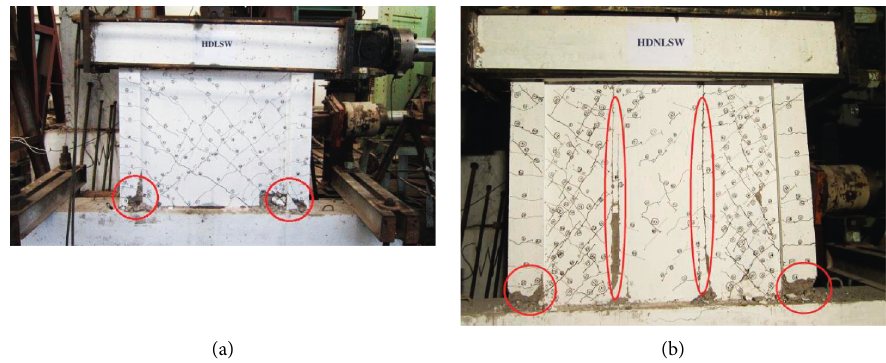
Figure 6: Crack development of the two specimens: (a) specimen HDLSW; (b) specimen HDNLSW.